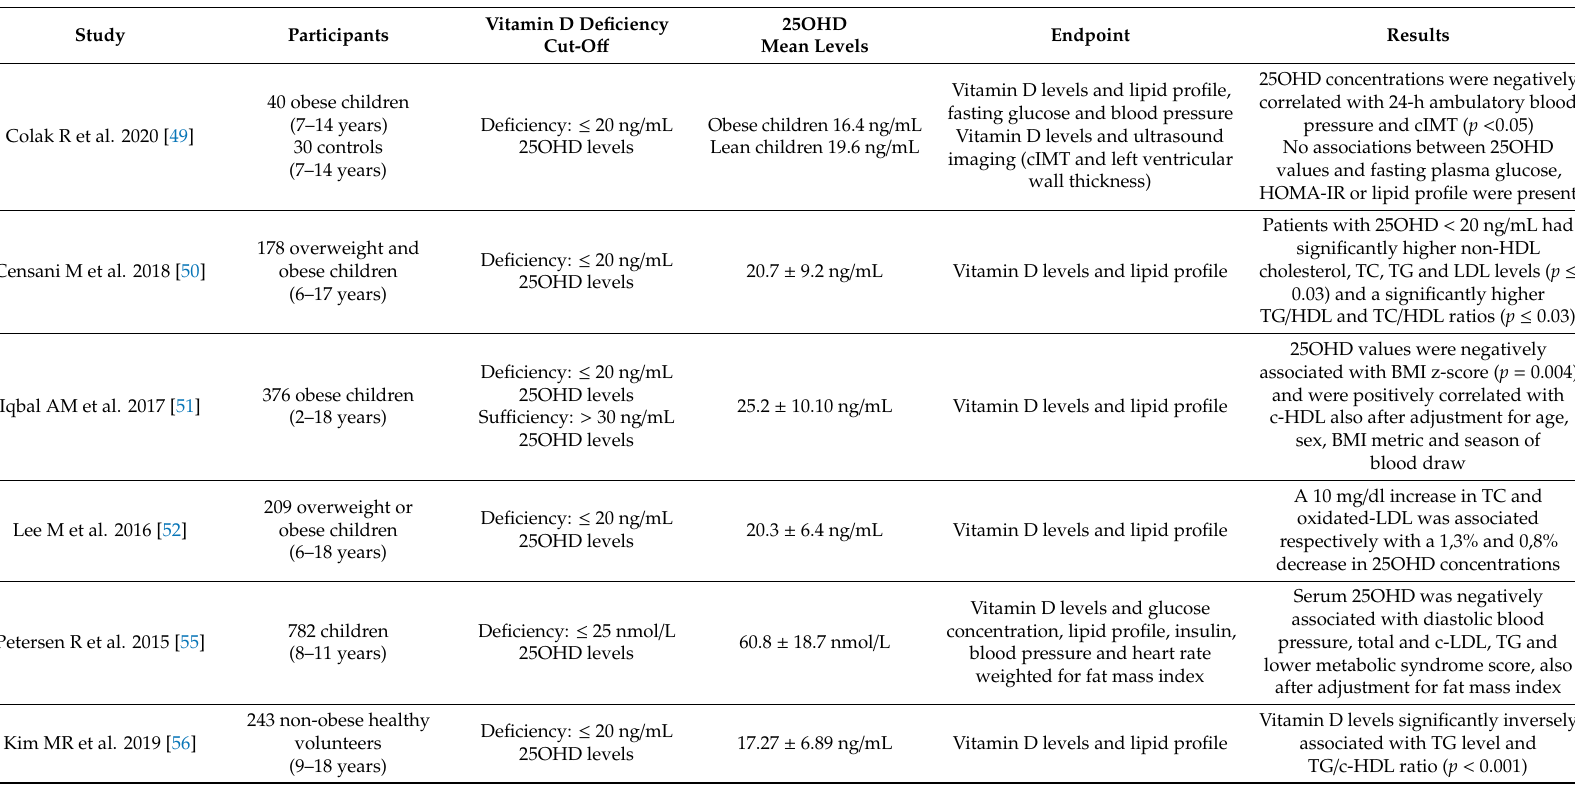
Table 1. Reviewed studies on Vitamin D deficiency and cardiovascular risk factors in pediatric age. cIMT: carotid intima-media thickness; BMI-z: BMI-for-age z-score; RAR: Retinoic Acid Receptor; RXR: Retinoid X Receptors; aIMT: aortic intima media